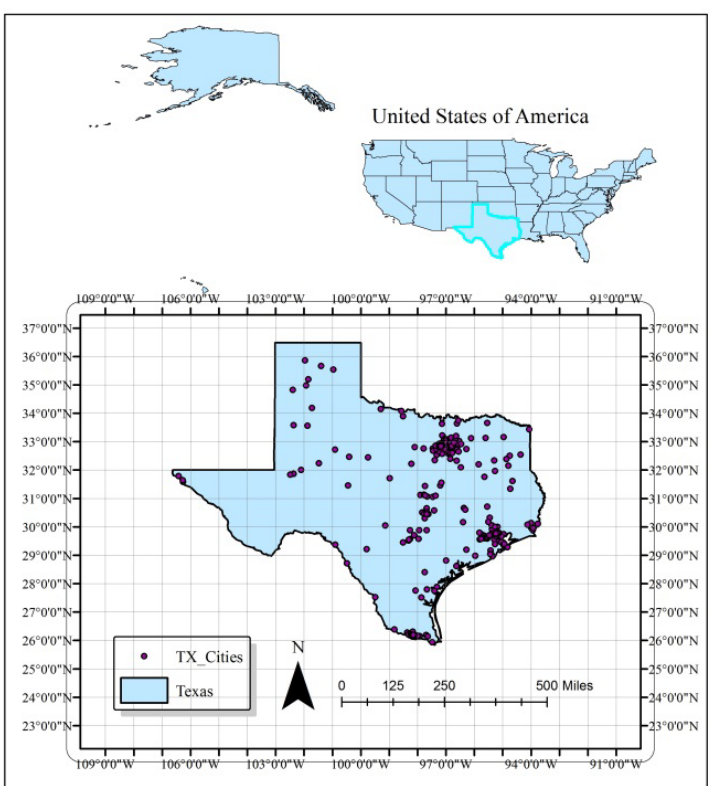
Figure 1. Location of Texas and its cities.